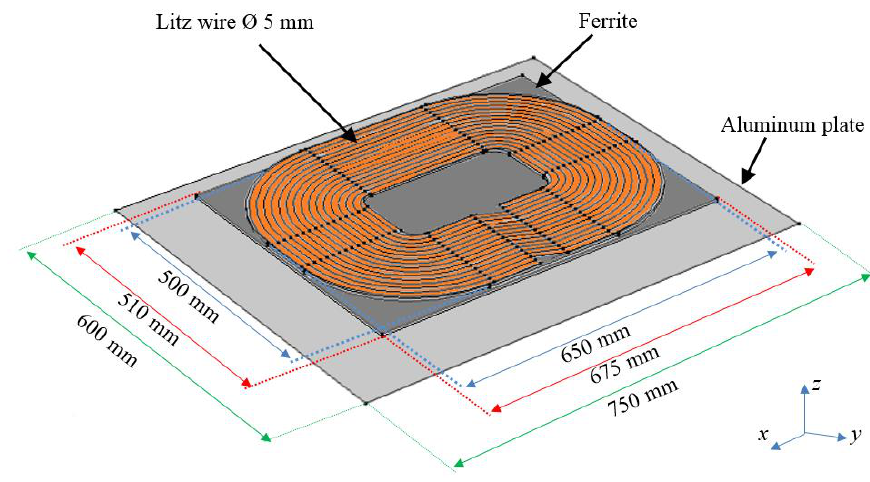
Figure 4. Electro-geometrical configuration of the GA coil.